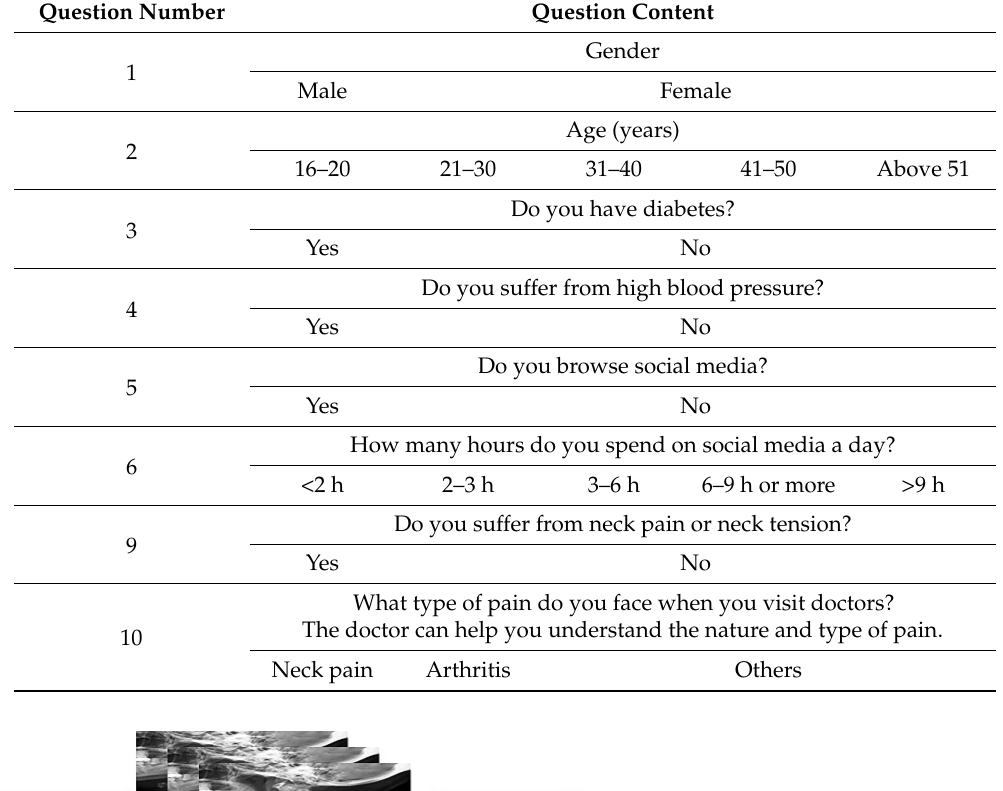
Table 1. Questionnaire (short survey) provided to patients during the orthopedic visit.